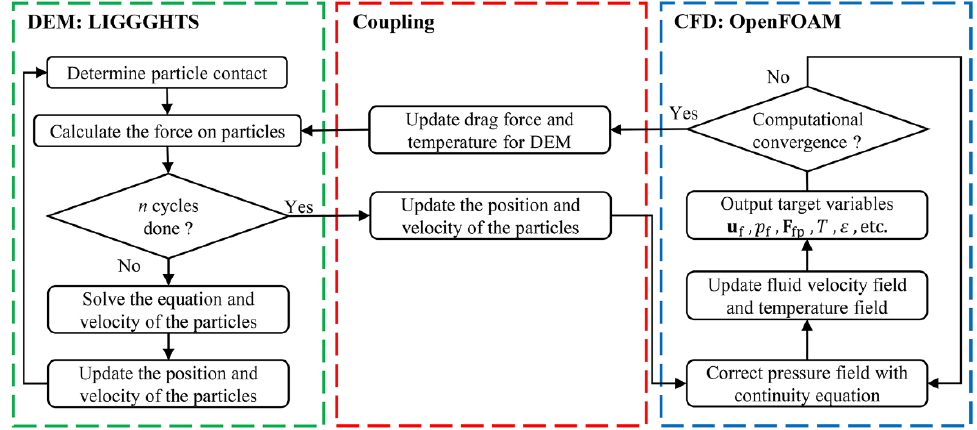
Figure 3. Flow chart of CFD-DEM model with coupling module between particles and fluid.